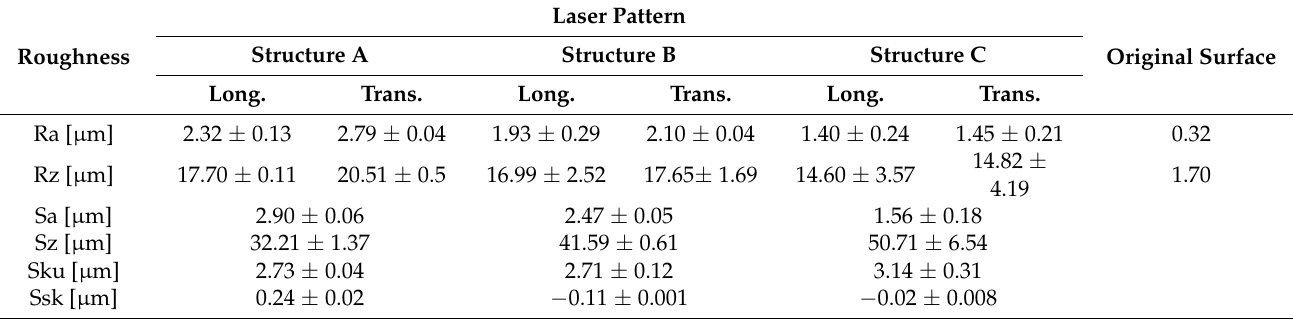
Original SurfaceStructure A Structure B Structure